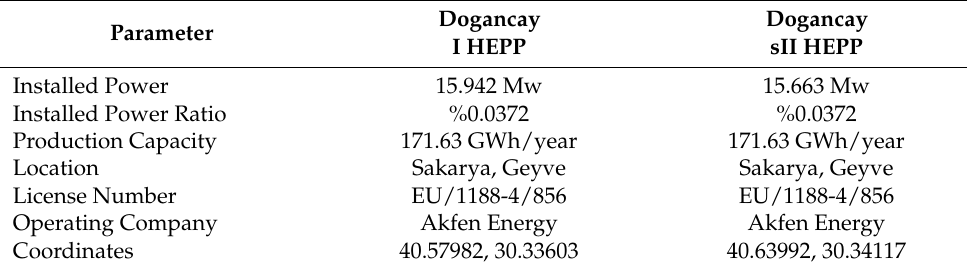
Figure 1. Location of Sakarya Province and Dogancay HEPPs on Turkey Basins Map. Table 1. General Features of Dogancay HEPPs.